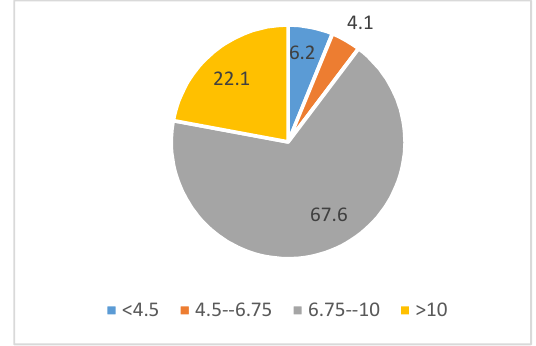
Fig. 2. The average salary of the participants in this